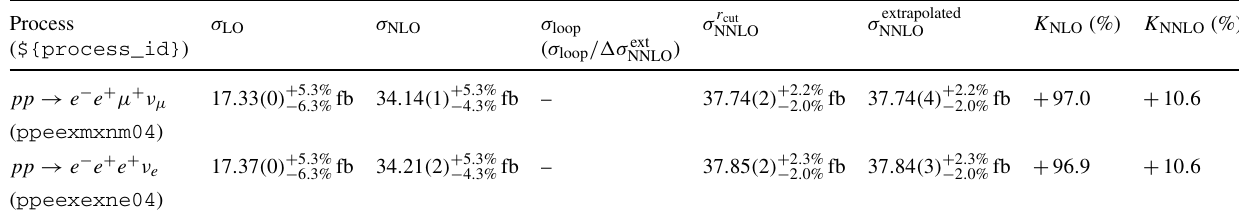
Table 7 Default setup of fiducial cuts for Z , W ± and γγ production processes